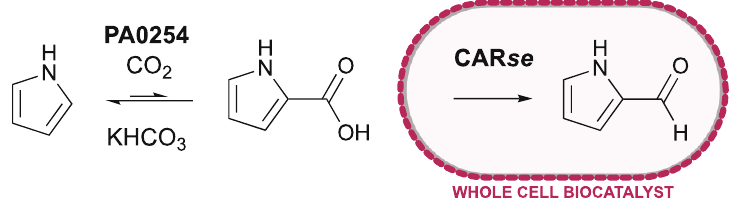
Figure 1. One-pot production of pyrrole-2-carbaldehyde, via a linked UbiD-CAR system, utilising whole-cell biocatalysts for improved cofactor economy.